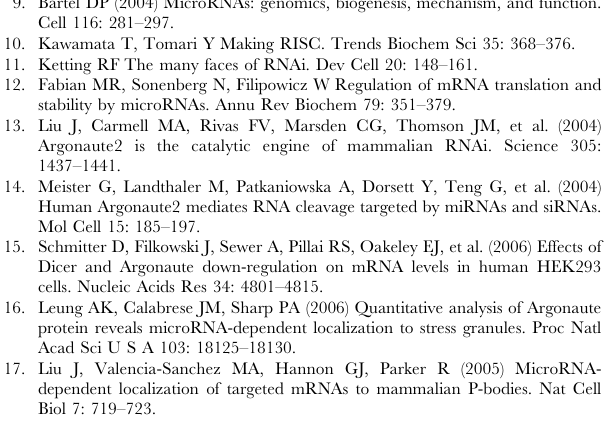
Figure S1 MiRNA profiling of HeLa mitochondria with or without RNase A treatment. Figure S2 Comparison of miRNA expression data in HeLa cells. Figure S3 Mitochondrial enrichment among predicted miRNA targets of mitomiRs and control miRNAs. Figure S4 Ontology enrichment analysis for target genes of hsa- miR-328, hsa-miR-494, hsa-miR-513 and hsa-miR-638. (TIFF) Supporting Information S1 Measurement of enzymatic activ- ities in mitochondrial fraction.